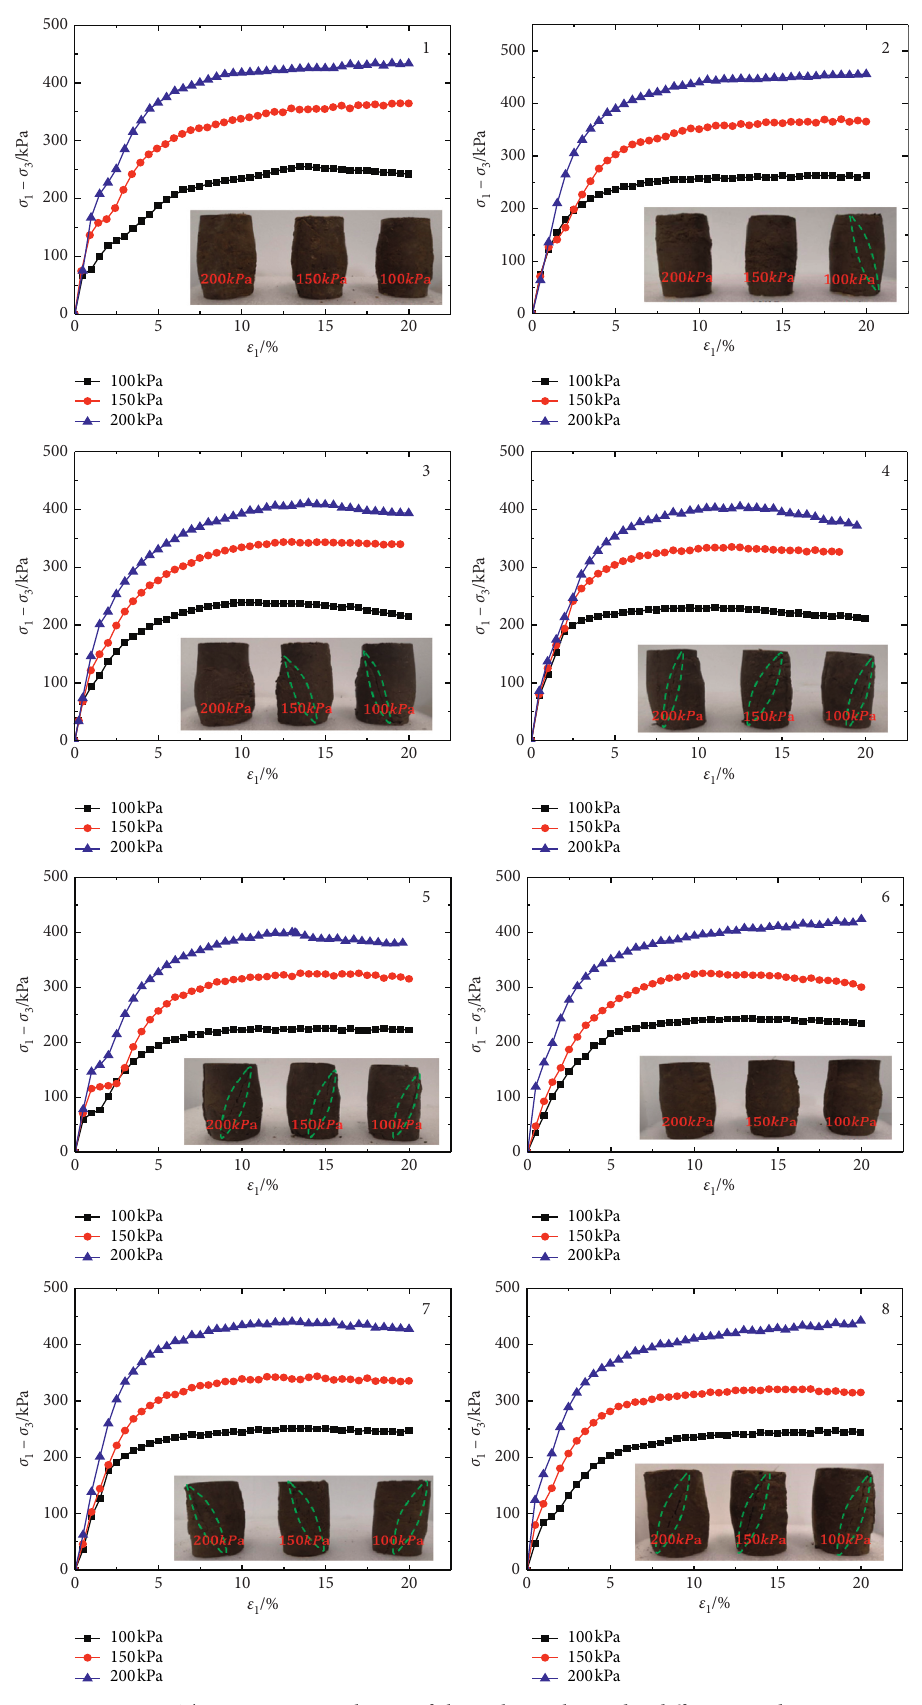
Figure 8: The stress-strain relation of the soil samples under different